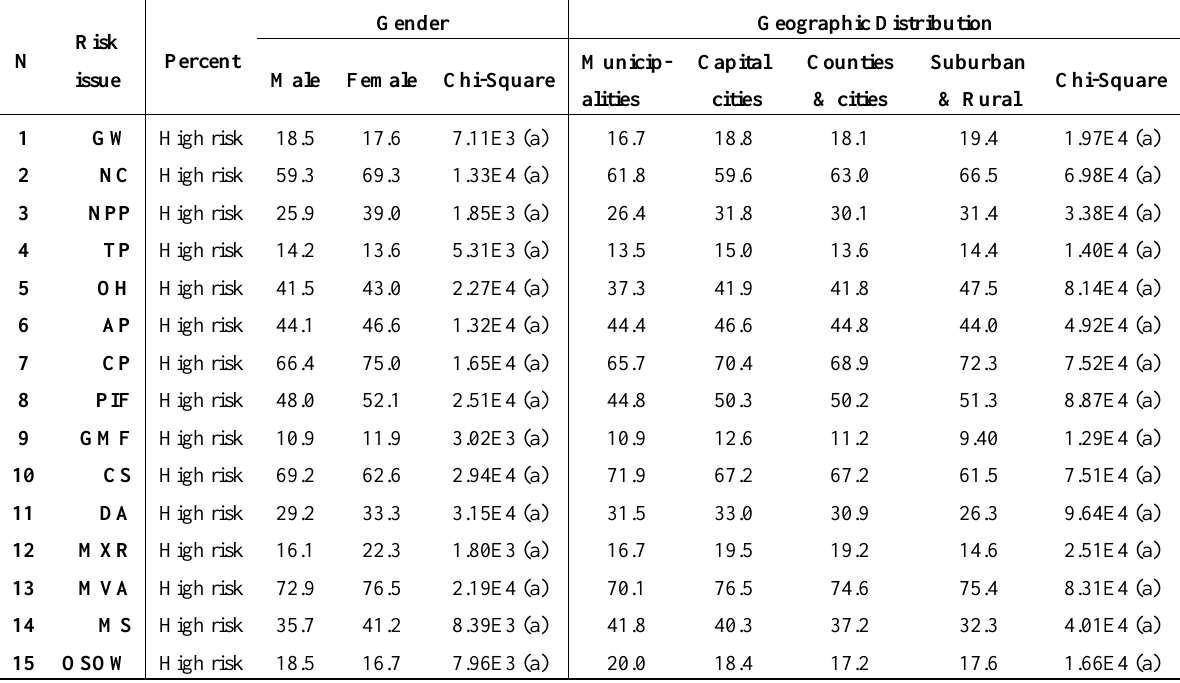
Table 3. Percent perceiving high health risk for selected hazards by demographic